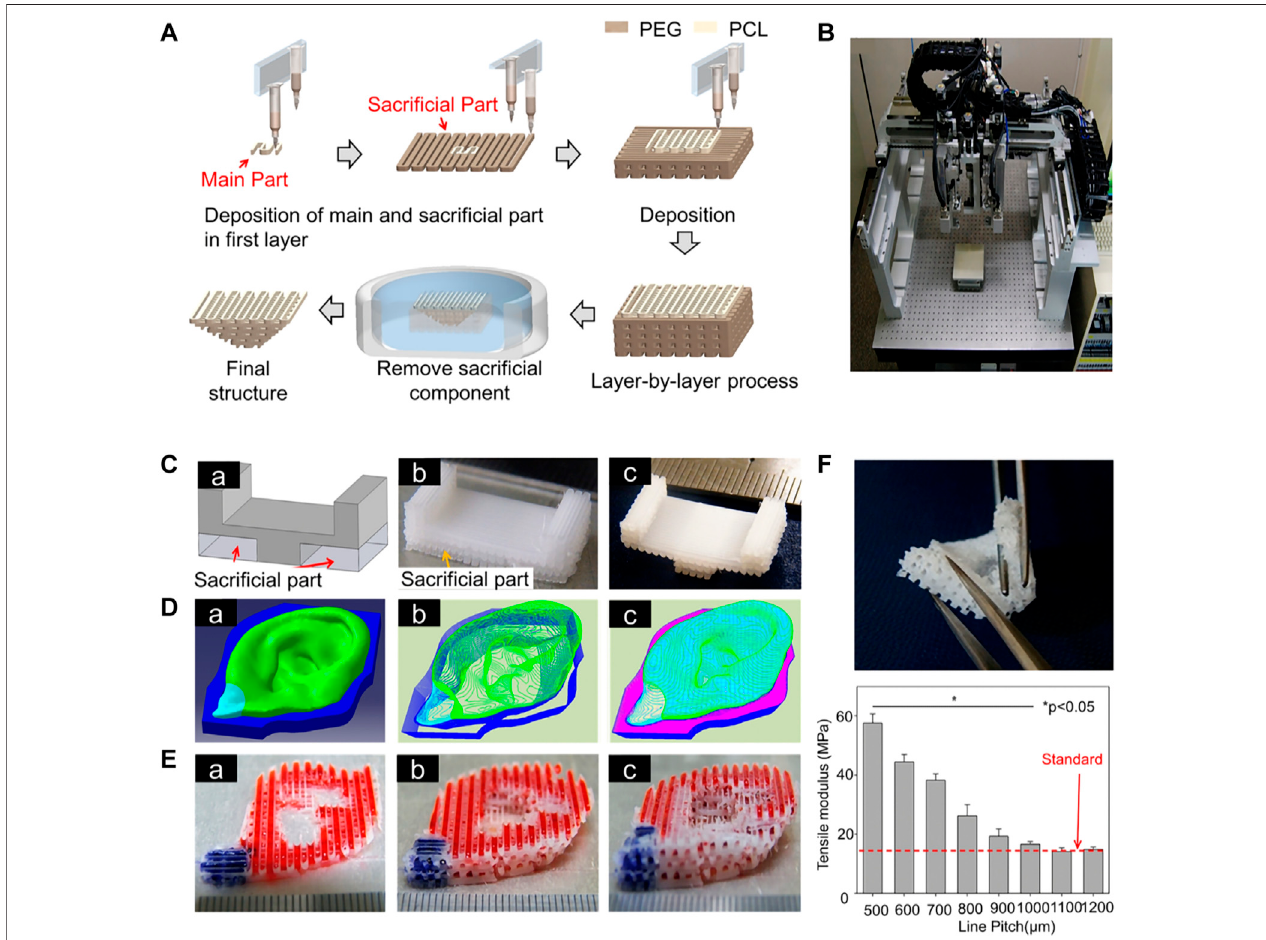
FIGURE 2 | 3D-printed auricular scaffold using sacri fi cial layer technology. (A) Fabrication of inverse porous pyramid structure employing sacri fi cial layer technology. (B) Schematic diagram of the multi-head tissue/organ building system (MtoBS). (C) Overhanging structure (20 mm × 10 mm × 6 mm). (D) The model